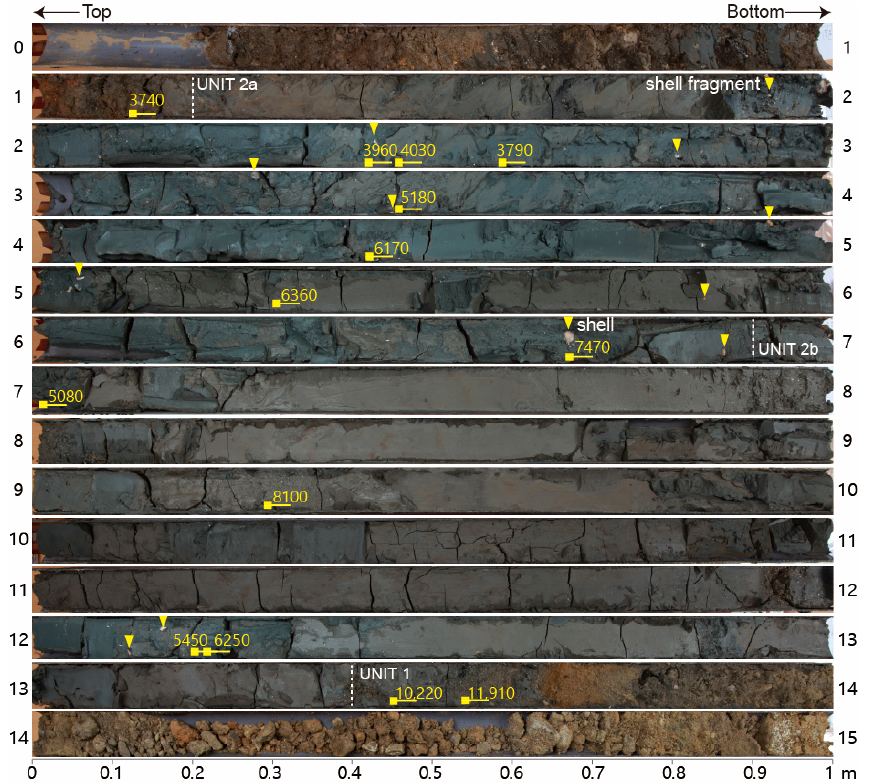
Figure 2. Photographs of core BSL11 recovered from the Deukryang area on the southwest coast of Korea. Yellow squares and numbers indicate the location of samples and ages of plant fragments at each depth. Yellow inverted triangles indicate shell locations. Dashed lines indicate boundaries be- tween each sedimentary unit.